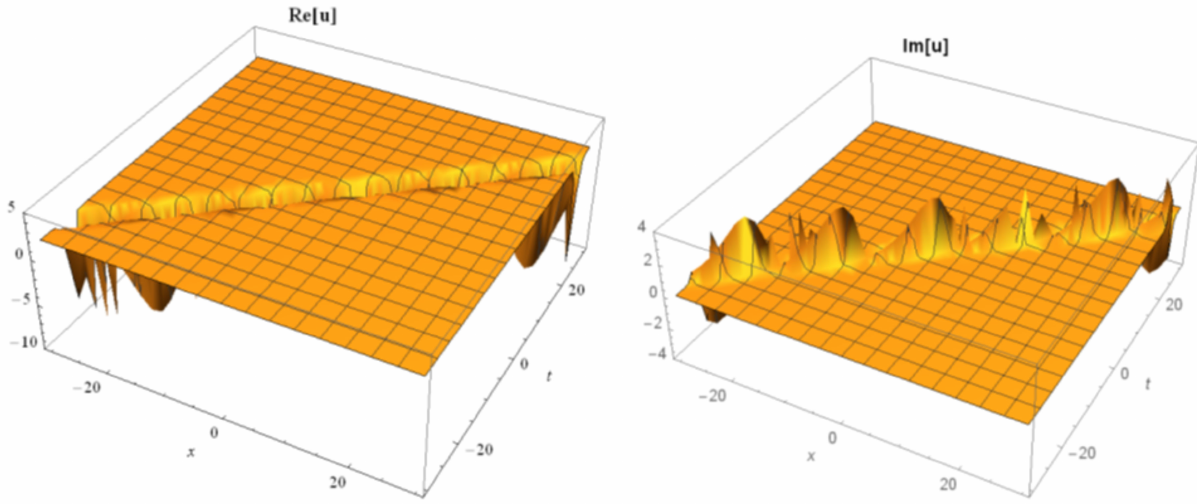
Figure 11. The 3D simulations of Equation (24) under the values of ε = 0.4, − 30 < x < 30, − 30 < t <